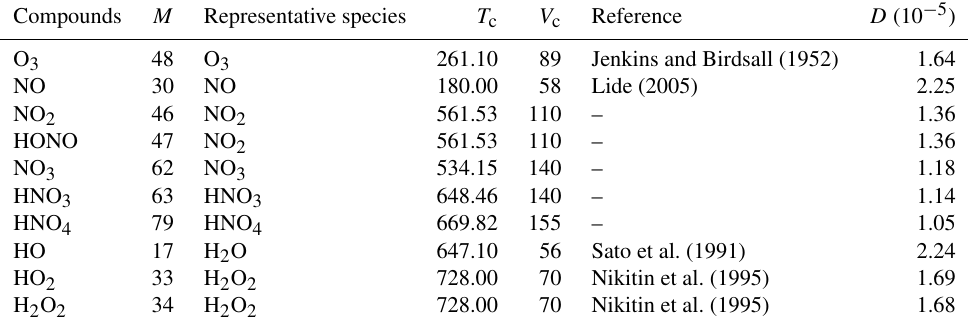
Table 2. Diffusion coefficients D [m 2 s − 1 ] and parameters used for their calculation following the procedure described in Sect. 2.4.1: RACM2 molar mass M [gmol − 1 ], critical temperature T c [K] and critical molar volume V c [cm 3 mol − 1 ] of representative species. Compounds